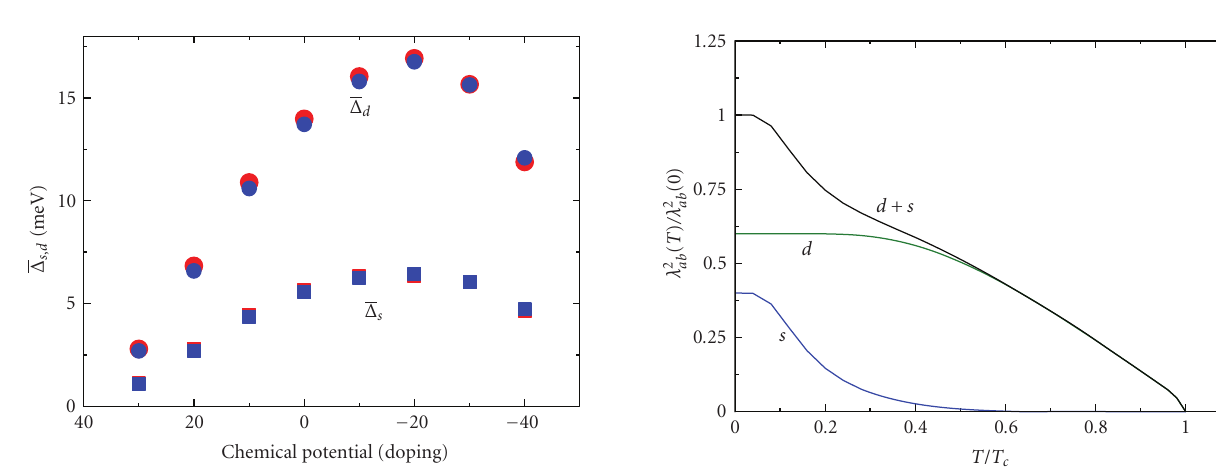
Figure 14: The individual components of λ 2 function of the normalized temperature T/T c (blue: s -wave; green: d -wave) to the total (black line) normalized in-plane penetration